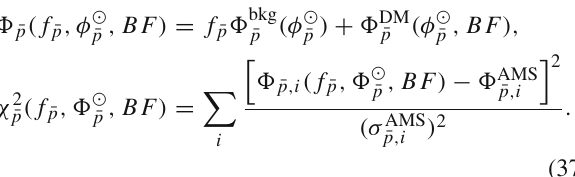
values of (cid:12) σv (cid:13) BF ≡ BF × (cid:12) σv (cid:13) 0 in table 3 with S E